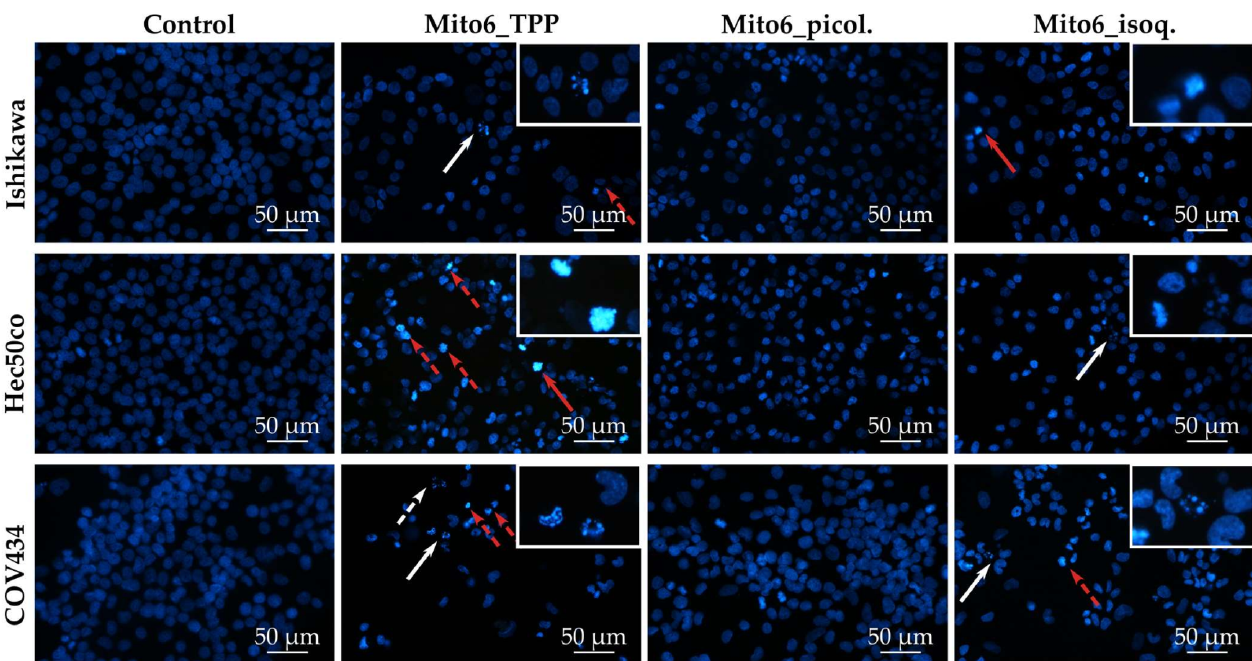
Figure 6. Cell morphology assessed by Höechst staining of Ishikawa, Hec50co, COV434, and HFF-1 cells after incubation with 5 µ M of Mito6_TPP, 20 µ M of Mito6_picol., or 10 µ M of Mito6_isoq. Untreated cells containing only the respective cell medium and 2% FBS were used as control. The results presented are representative of at least three independent experiments. White arrows indicate examples of nucleus fragmentation and red arrows indicate examples of chromatin condensation. The white boxes contain higher magnification images containing the nucleus fragmentation or chromatin condensation indicated by the full arrows. The traced arrows are not in the enlarged